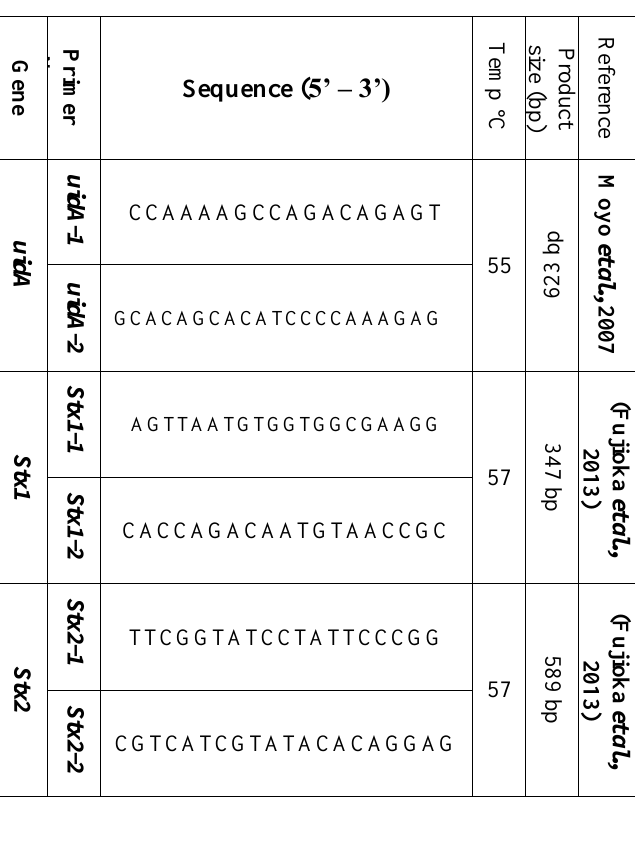
Table1: Primers used for